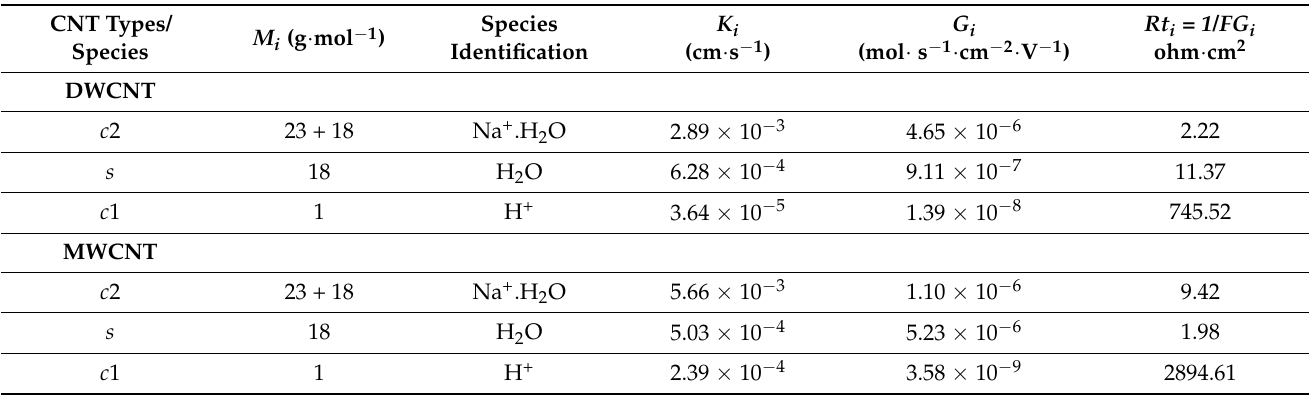
Table 1. K i (kinetics of transfer), and G i (inverse of the transfer resistance), Rt i (transfer resistance) values extracted from the fitting results from AC-electrogravimetric measurements in aqueous 0.5 M NaCl at –0.4 V vs. Ag/AgCl for DWCNT and MWCNT